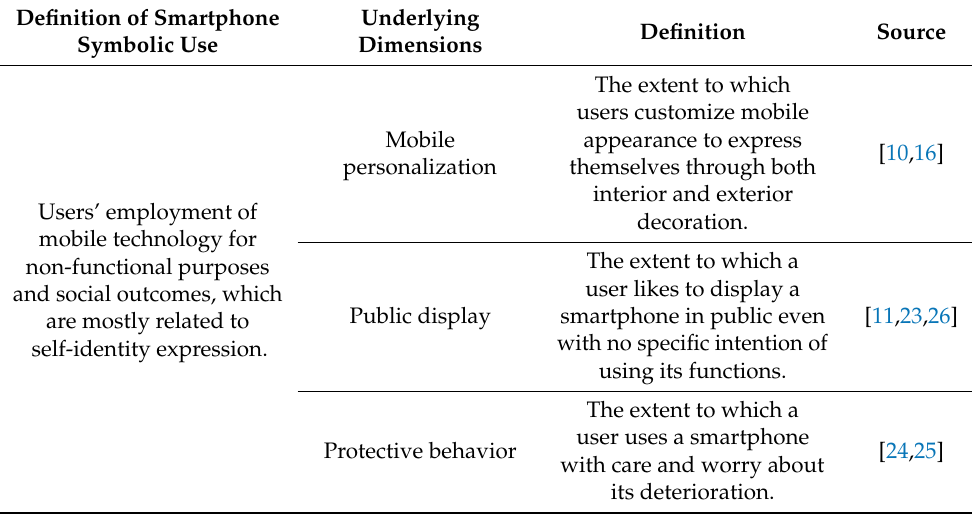
Table 1. Definition of smartphone symbolic use and its underlying